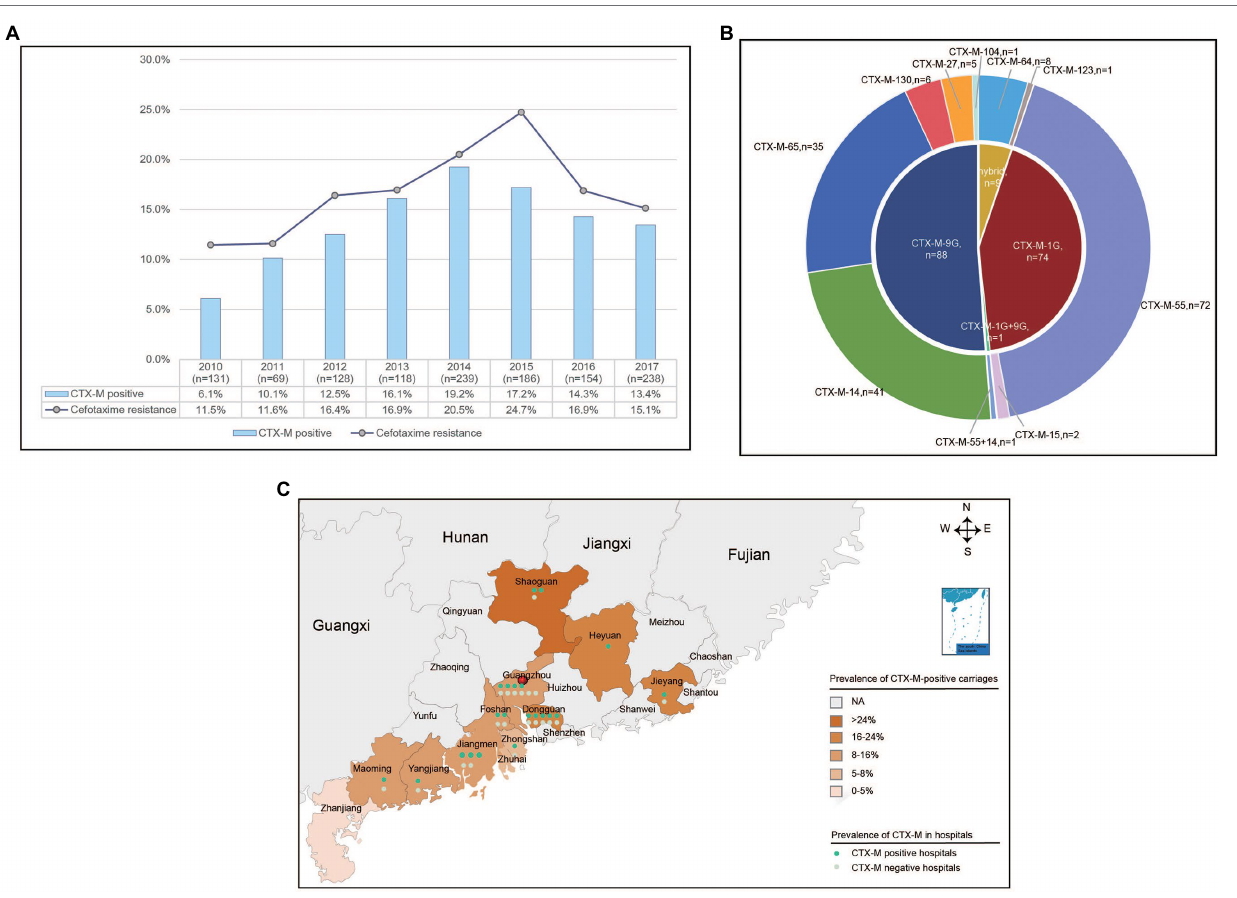
FIGURE 1 | The prevalence of bla CTX-M -positive Salmonella Typhimurium isolates from diarrhoeal patients in 11 hospitals in Guangdong Province, China from 2010 to 2017. (A) The rate of resistance to cefotaxime and detection rate of bla CTX-M -positive S. Typhimurium isolates in Guangdong Province from 2010 to 2017. (B) The subtypes and numbers of variants in CTX-M. (C) The detection rate of bla CTX-M -positive S. Typhimurium isolates in 11 cities in Guangdong Province.